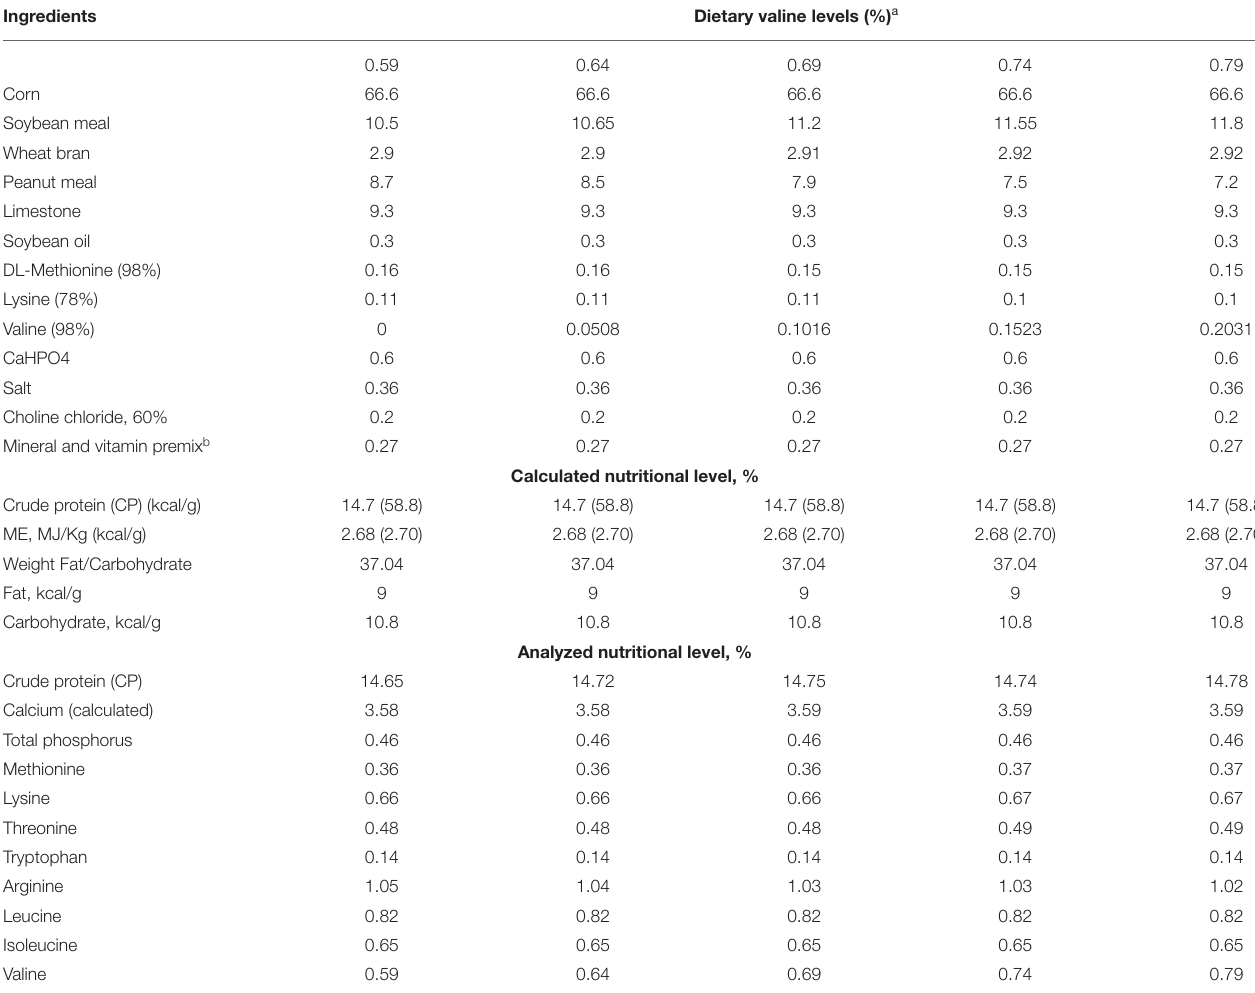
TABLE 1 | Composition and nutrient levels of the basal diet (air-dry basis).